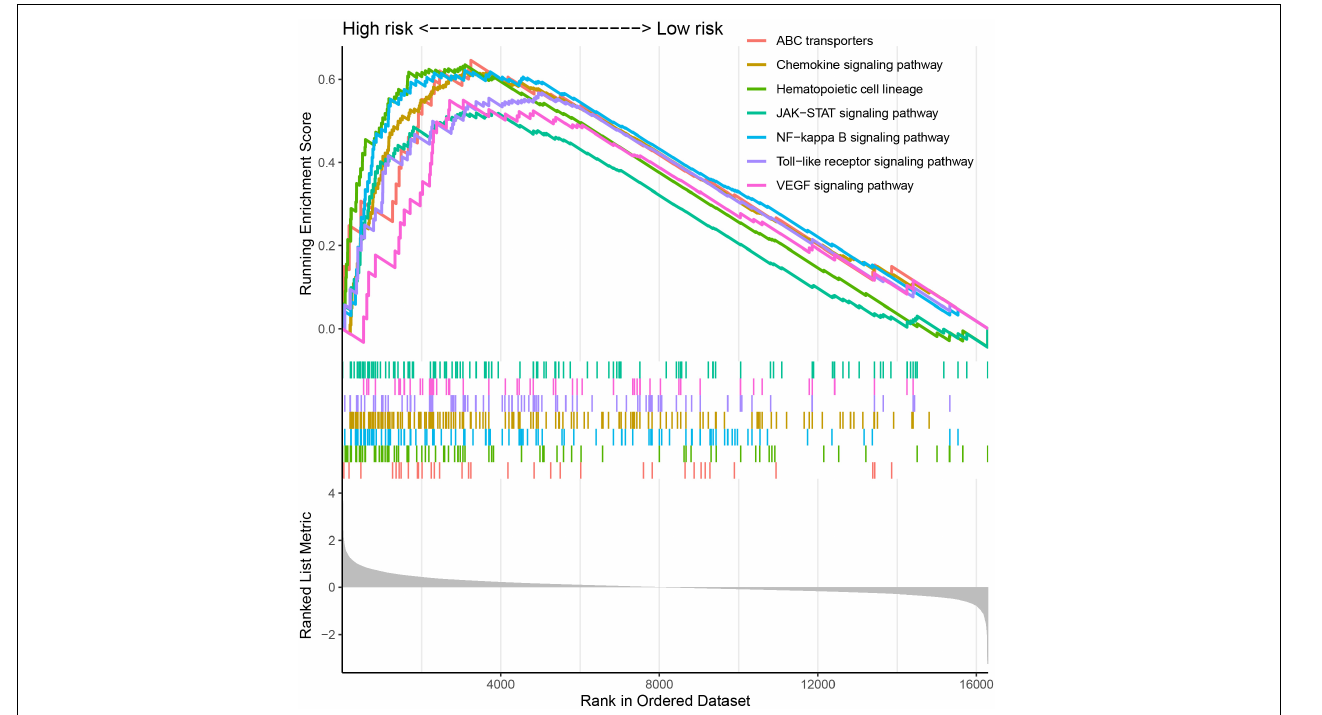
FIGURE 7 | The significantly enriched KEGG pathways by Gene Set Enrichment Analyses